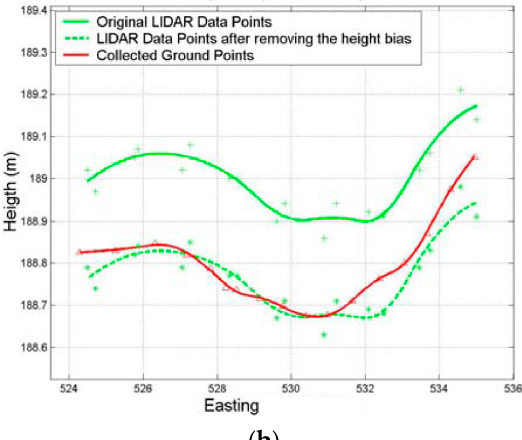
Figure 8. Height differences histogram between the laser height and the ground height.